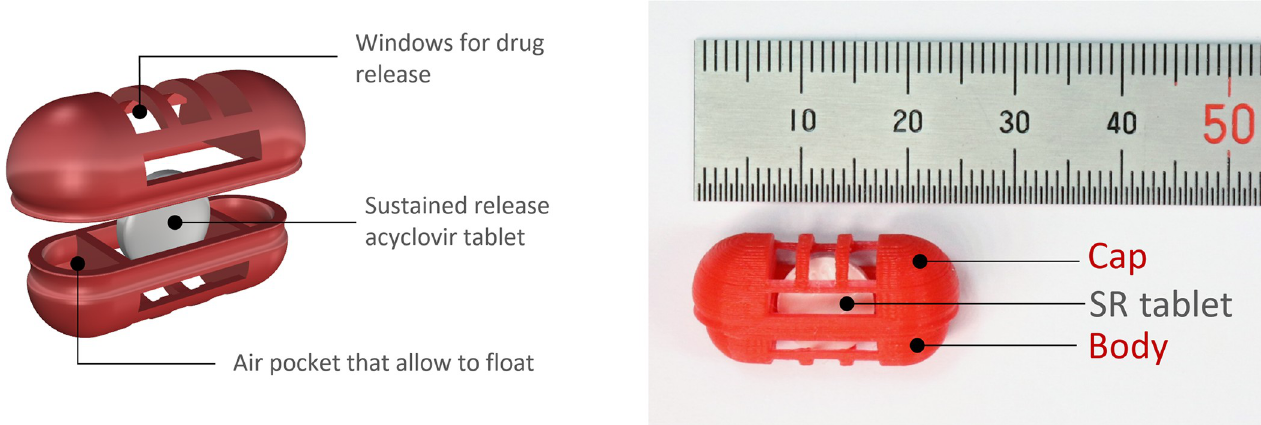
Fig 1. The structure of the gastroretentive (GR) system. The novel GR system composed of the 3D printed gastro-floating device and acyclovir sustained- release (SR) tablet inside the device.